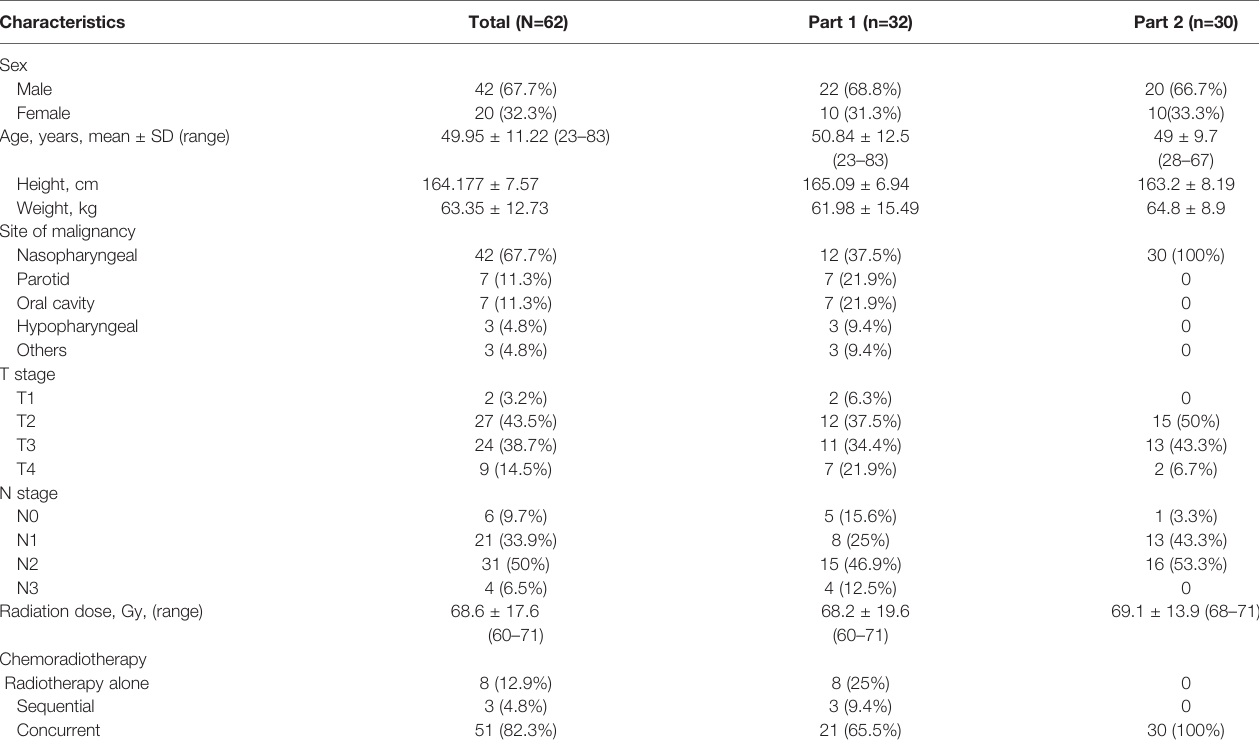
TABLE 1 | Patient characteristics (N=62).